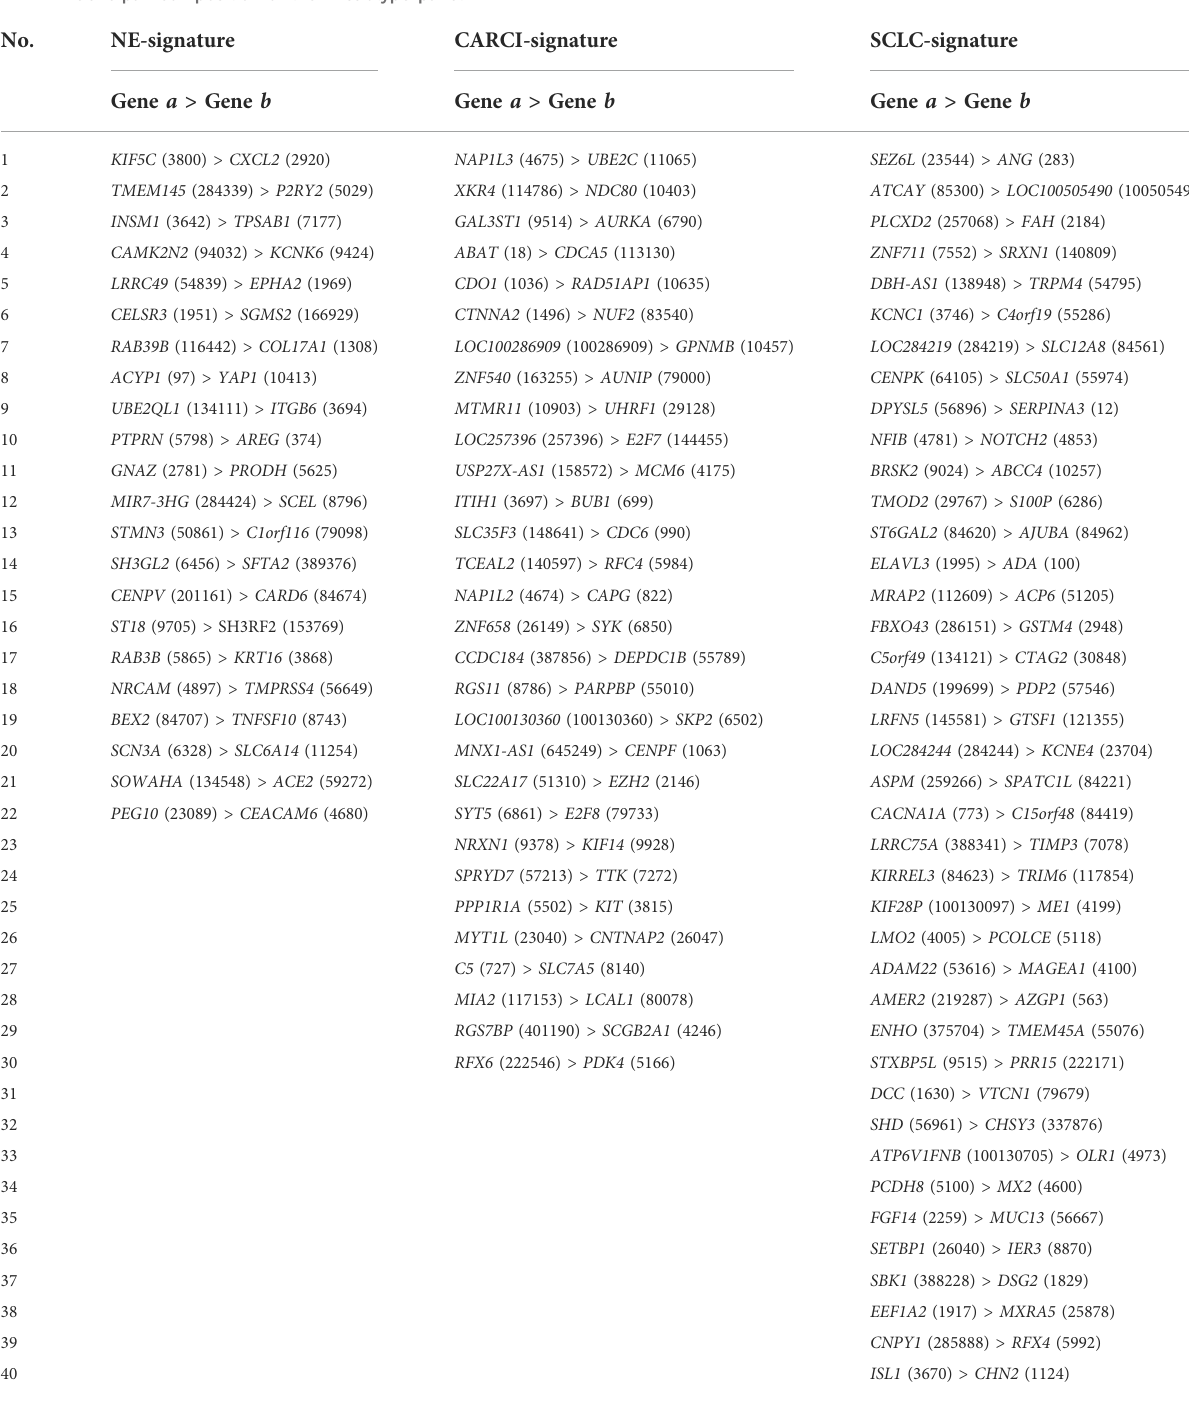
TABLE 1 Gene pair composition of the